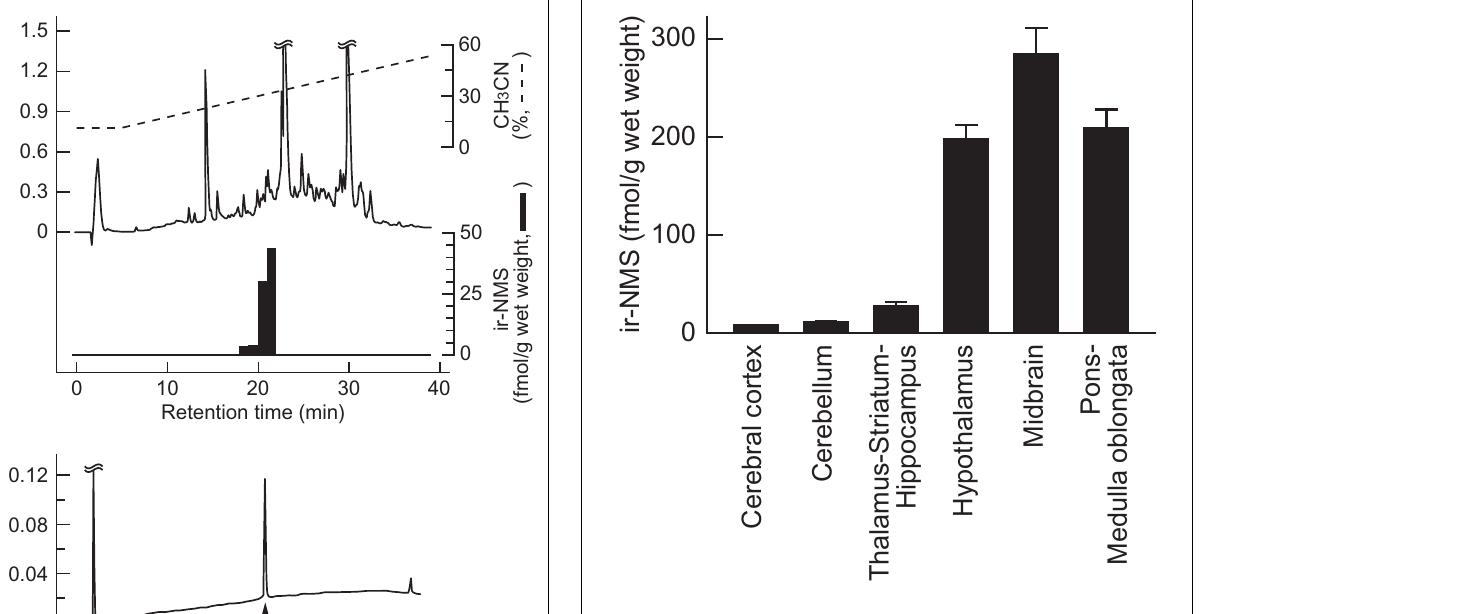
FIGURE 3 | Regional distribution of immunoreactive neuromedin S (ir-NMS) in rat brain. Concentrations of ir-NMS in various brain areas were quantified by radioimmunoassay.The brains were sampled during the light period. Data represent means ± SEM of three rats. (4.20 ± 0.16 copies/ng total RNA), and pons–medulla oblongata (4.76 ± 0.40 copies/ng total